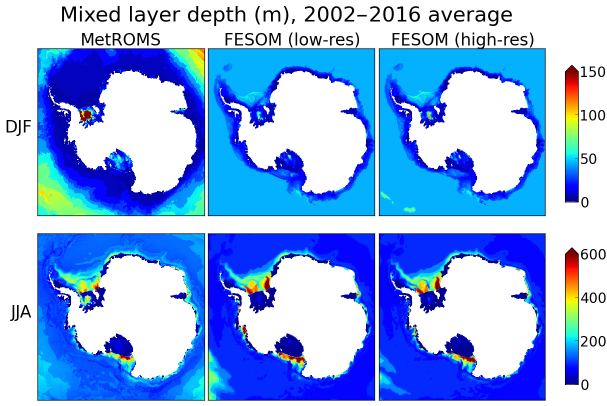
Figure 3. As Fig. 2 for each model simulation, zoomed into the Antarctic continental